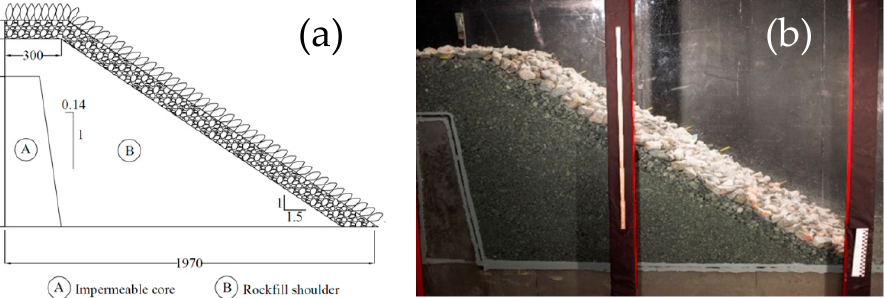
Figure 6. ( a ) Depiction of experimental setup of half dam model with core and ( b ) image of dumped riprap model with such setup from [26].